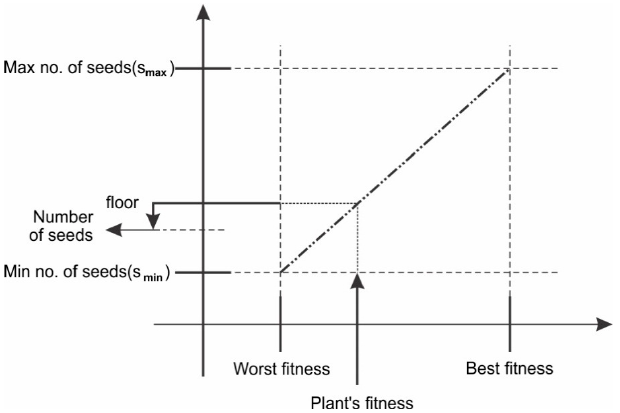
Figure 8. Procedure of seed reproduction at weeds' colony [77].